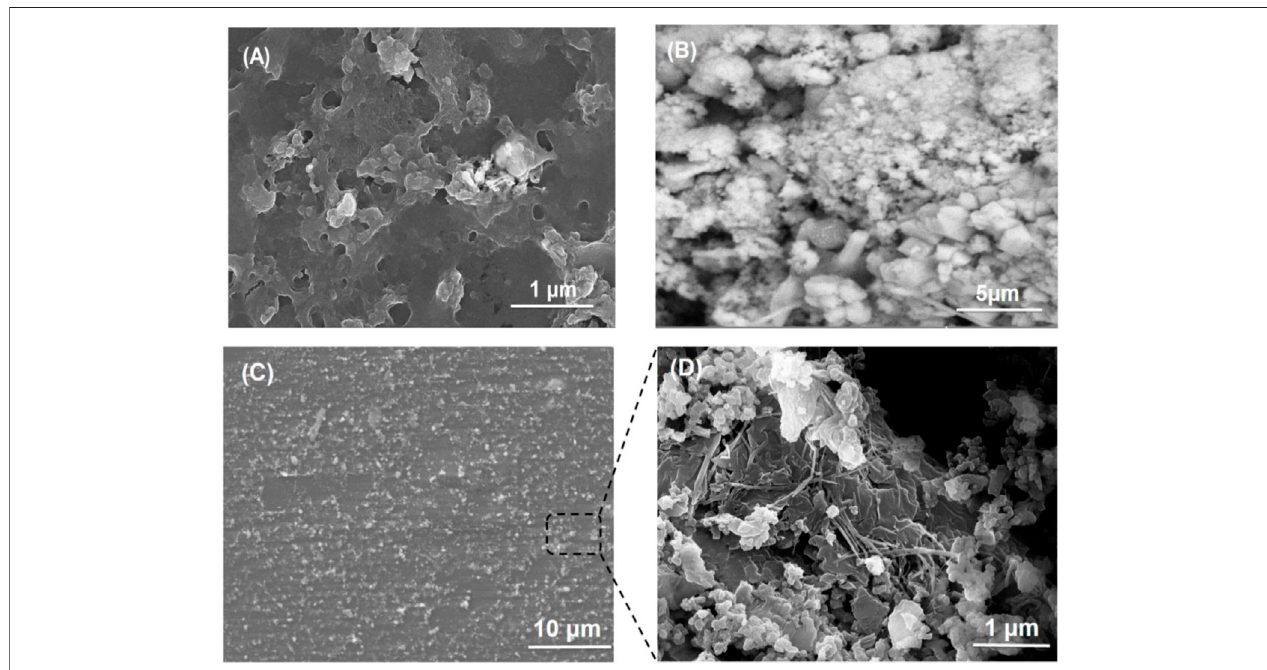
FIGURE 4 | SEM images of (A) PVA/mucilage, (B) Lignin@ZnO, and (C) Lignin@ZnO-GTR membrane, and (D) zoom image of the cross section from (C).